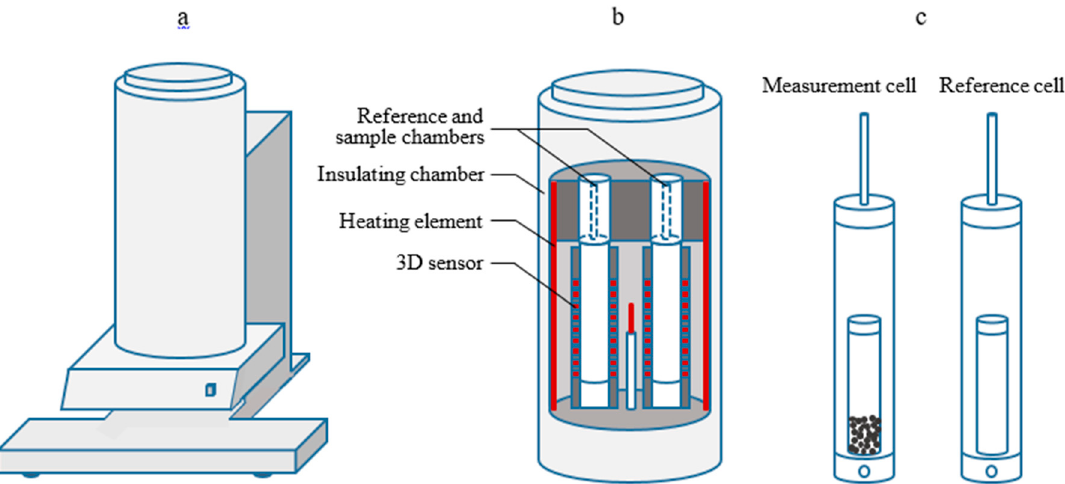
Figure 1. ( a ) General view of the C80 micro-calorimeter from Setaram; ( b ) the heating block showing the geometry for the reference and measurement cells; ( c ) the Hastelloy reversing mixing cells utilized in the current work and their contents.